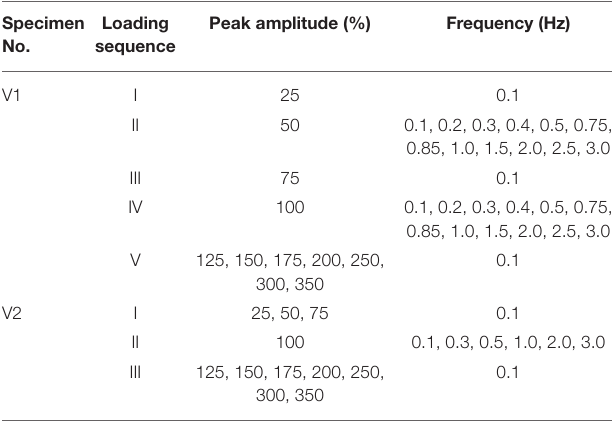
TABLE 3 | Loading protocol of VE dampers. Specimen